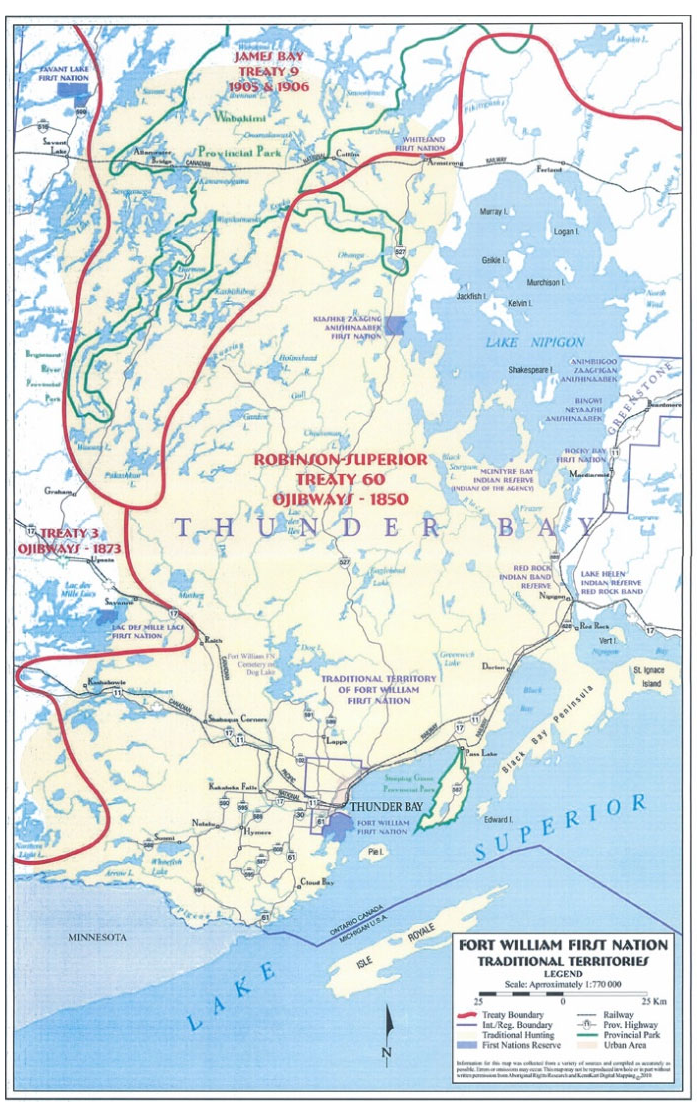
Source: Fort William First